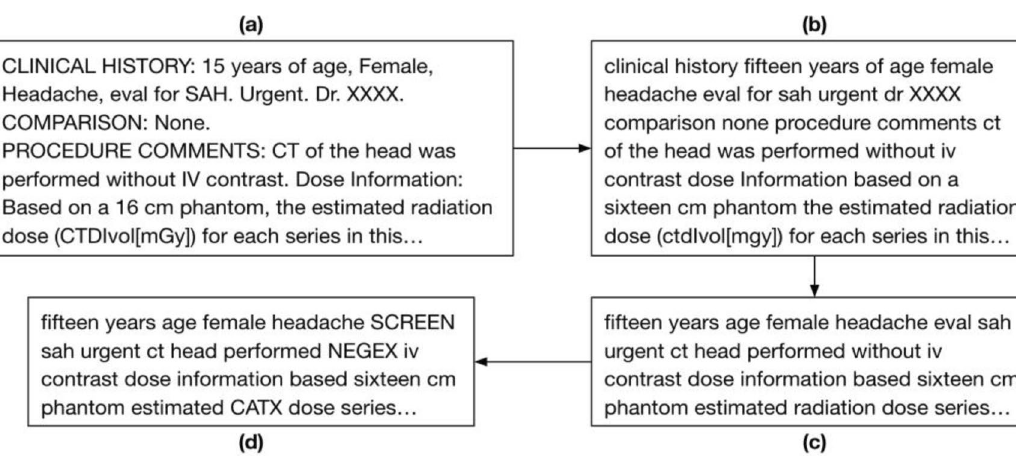
Figure 7. Pictorial representation of a free-text radiology report ( a ), transformed through the preprocessing steps of text cleaning ( b ), unwanted phrase removal ( c ), and word mapping ( d